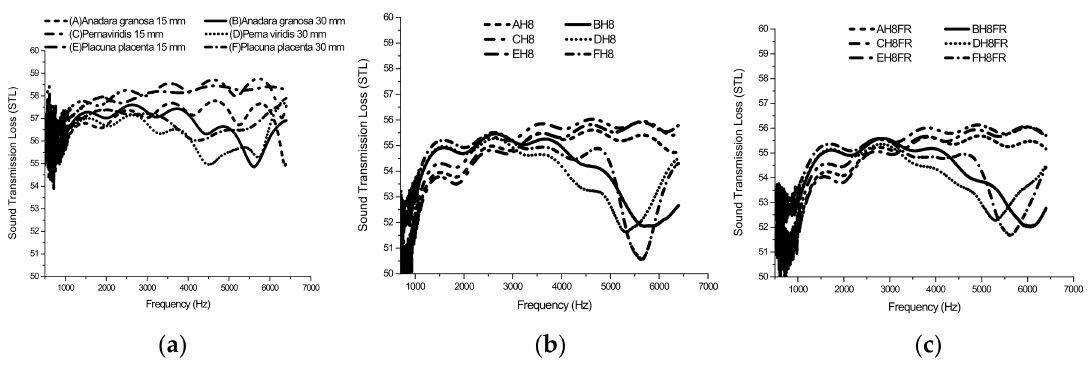
Figure 9. STL SFRP ( a ) without treatment; ( b ) with 8 resonators; ( c ) with 8 resonators and fibrous